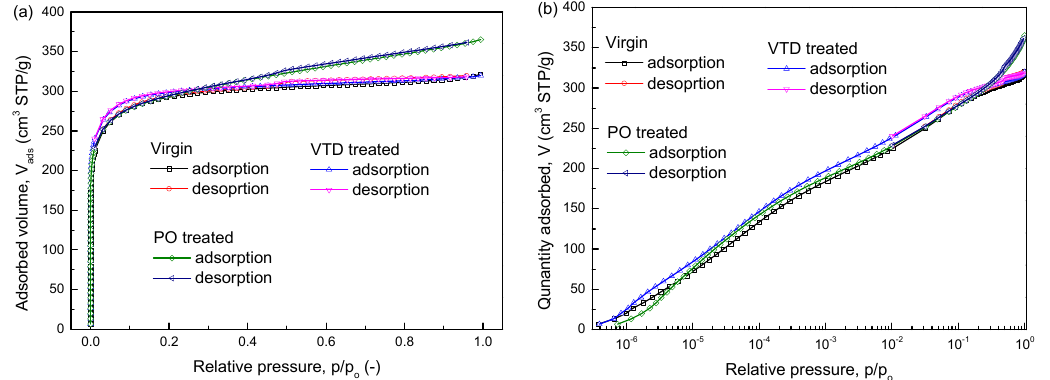
Figure 1. High-resolution N 2 sorption and desorption isotherms for virgin, vacuum thermal desorption (VTD) treated and partial oxidation (PO) treated granular activated carbon (GAC) samples: ( a ) linear scale and ( b ) log scale.